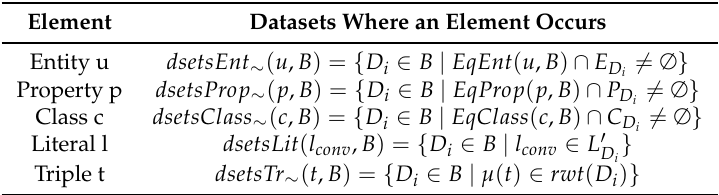
Table 2. Notations for finding the provenance of different